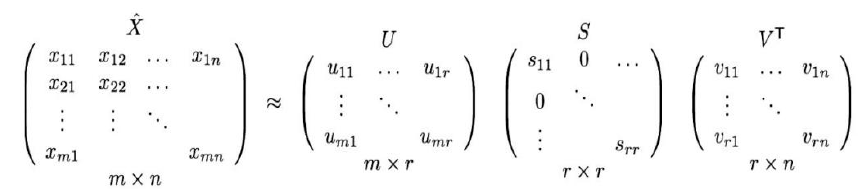
Figure 7. Singular value decomposition.